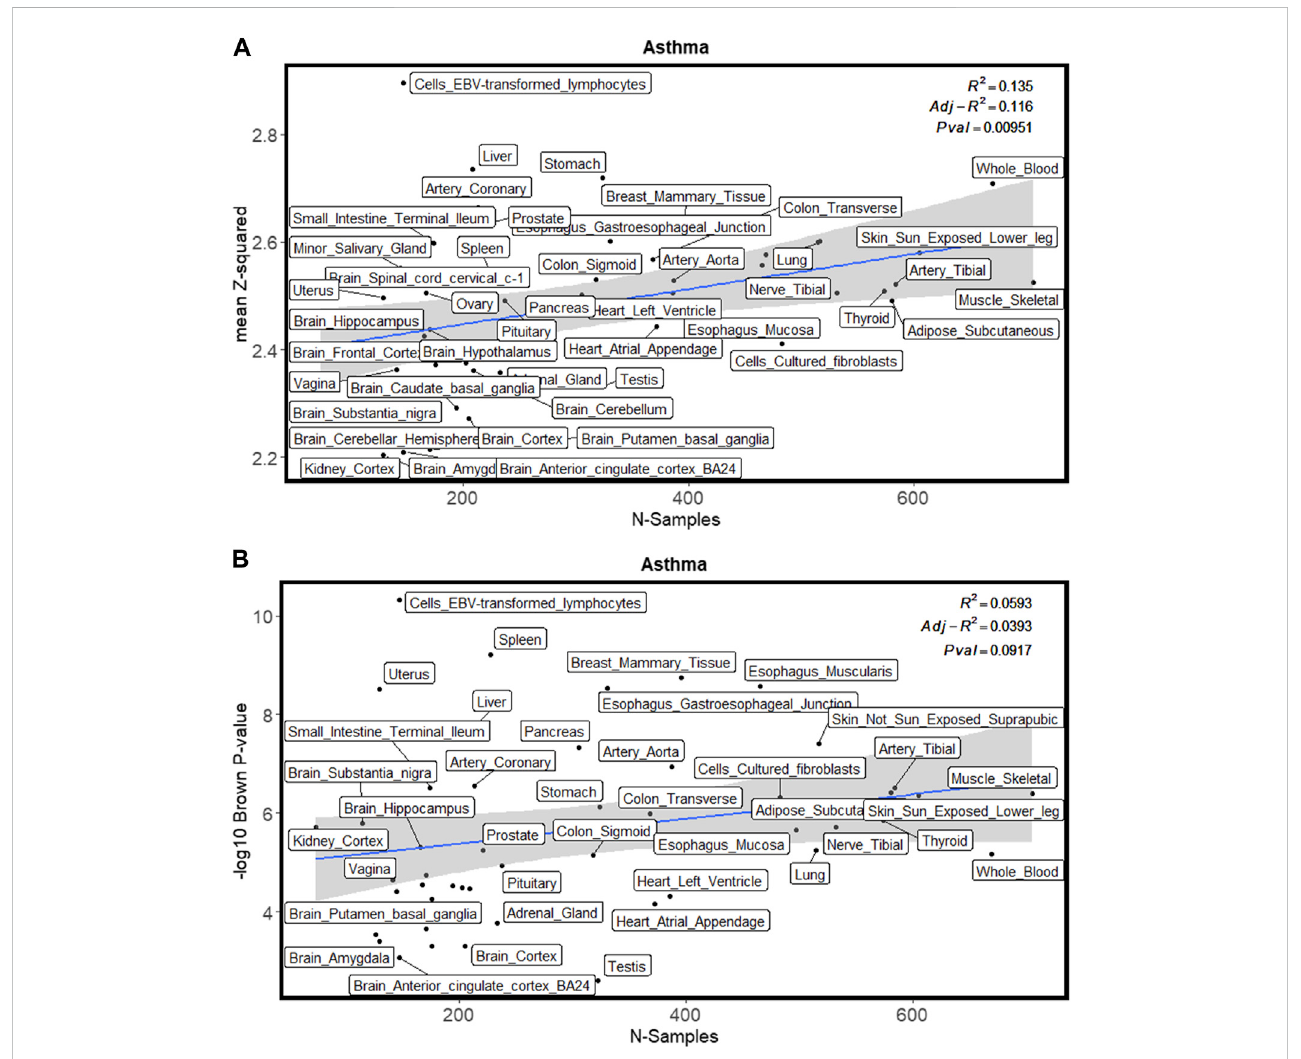
FIGURE 2 EnrichmentmethodsusedinthisstudyforoneofthetrainingGWAS(asthma)datasets. (A) showstheenrichmentwithameansquaredz-score. (B) shows enrichment with Brown ’ s p